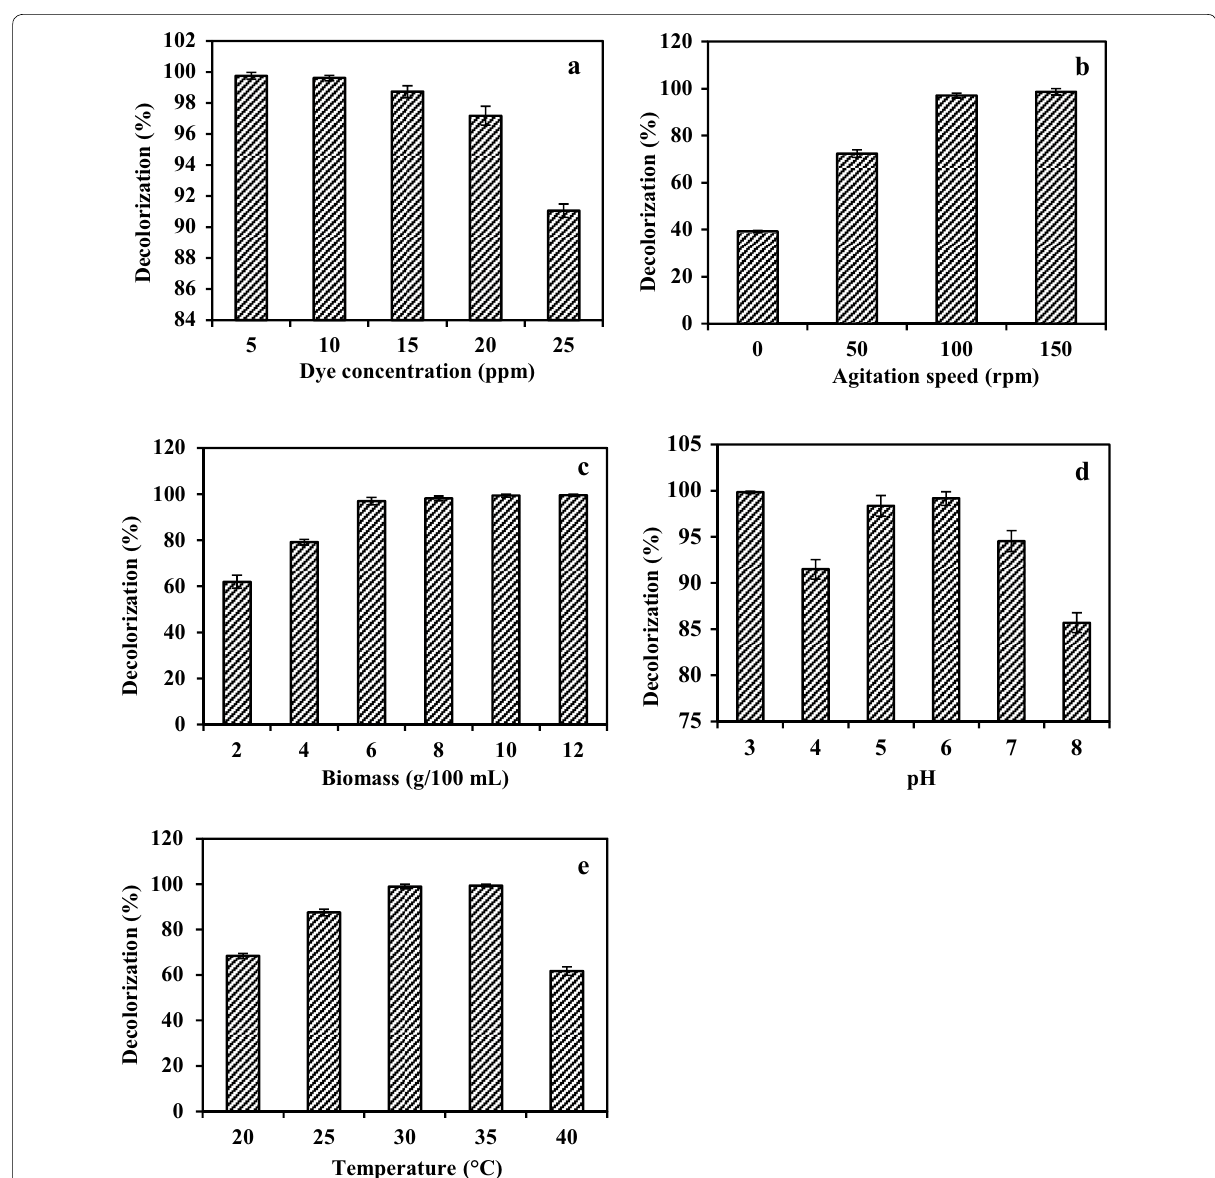
Fig. 3 a Effect of initial dye concentration (pH: 6; temperature: 30 °C; agitation speed: 120 rpm; biomass concentration: 8 g), b agitation speed (pH: 6; temperature 30 °C; biomass concentration: 8 g; dye concentration: 20 mg/L), c biomass concentration (pH: 6; temperature 30 °C; dye concentra- tion: 20 mg/L; agitation speed: 150 rpm), d pH (temperature 30 °C; dye concentration: 20 mg/L; agitation speed: 150 rpm; biomass concentration: 6 g) and e temperature (pH: 6; dye concentration: 20 mg/L; agitation speed: 150 rpm; biomass concentration: 6 g) on RR31 decolorization using potent fungal culture after 12 h of incubation